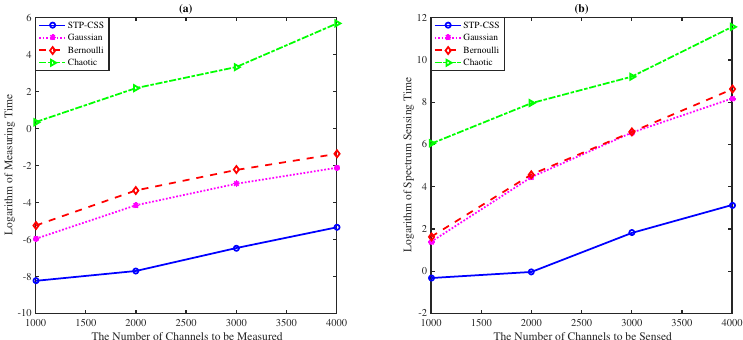
Figure 10. The comparisons of time costs on the measurement process and the whole spectrum sensing process. The numbers of the channels were set to 1000, 2000, 3000, and 4000. ( a ) The logarithm of measuring time. ( b ) The logarithm of sensing